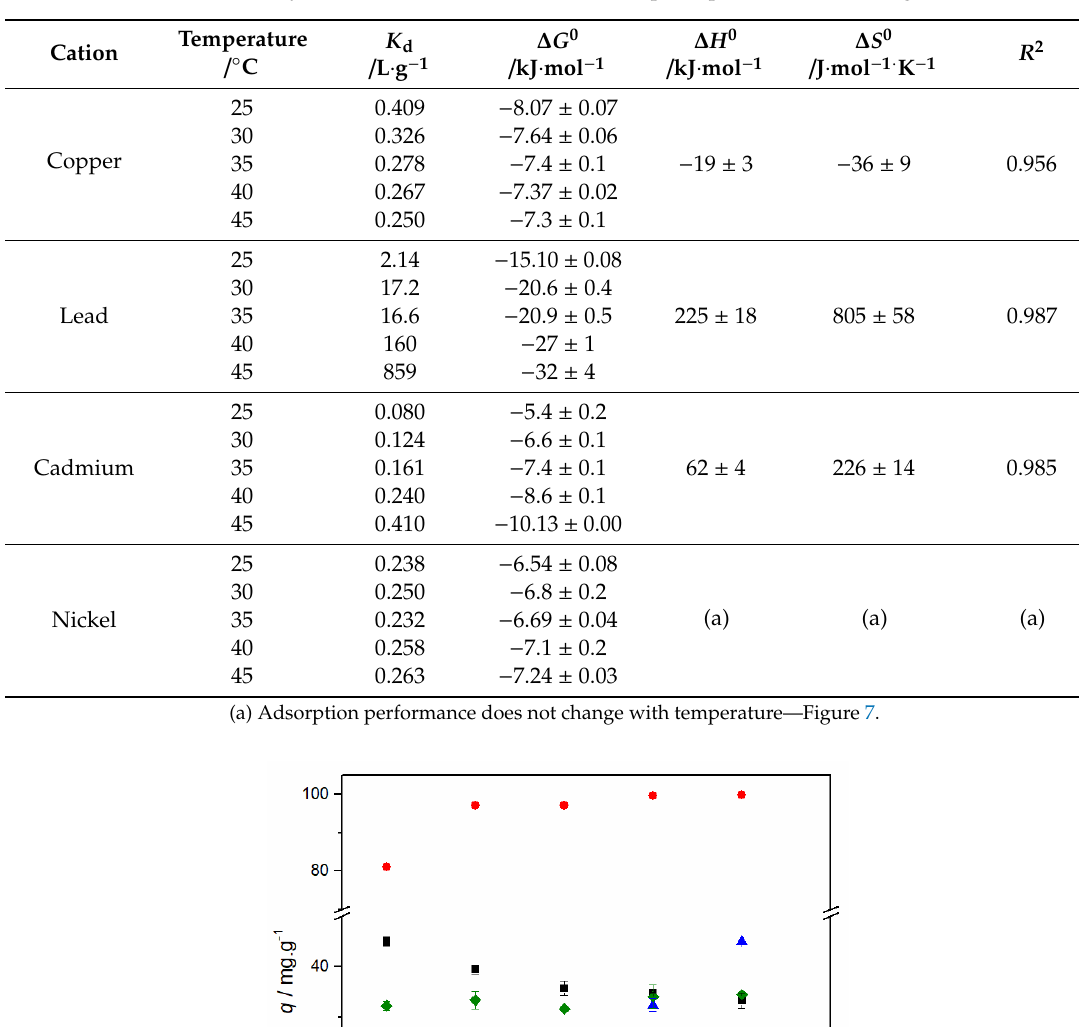
Table 7. Thermodynamic characterization of the adsorption process for the aerogel A + 3A.